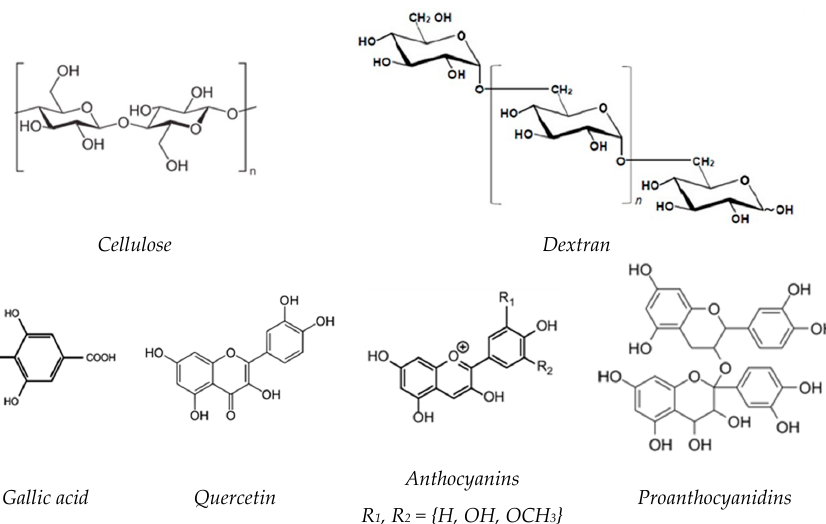
Figure 1. Chemical structure of cellulose, dextran and the major phenolic compounds identified in grape seeds.